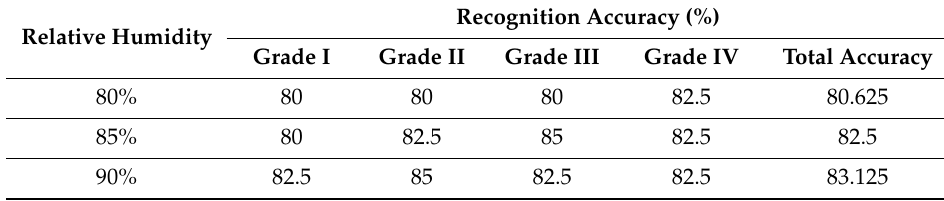
Table 4. Recognition results of